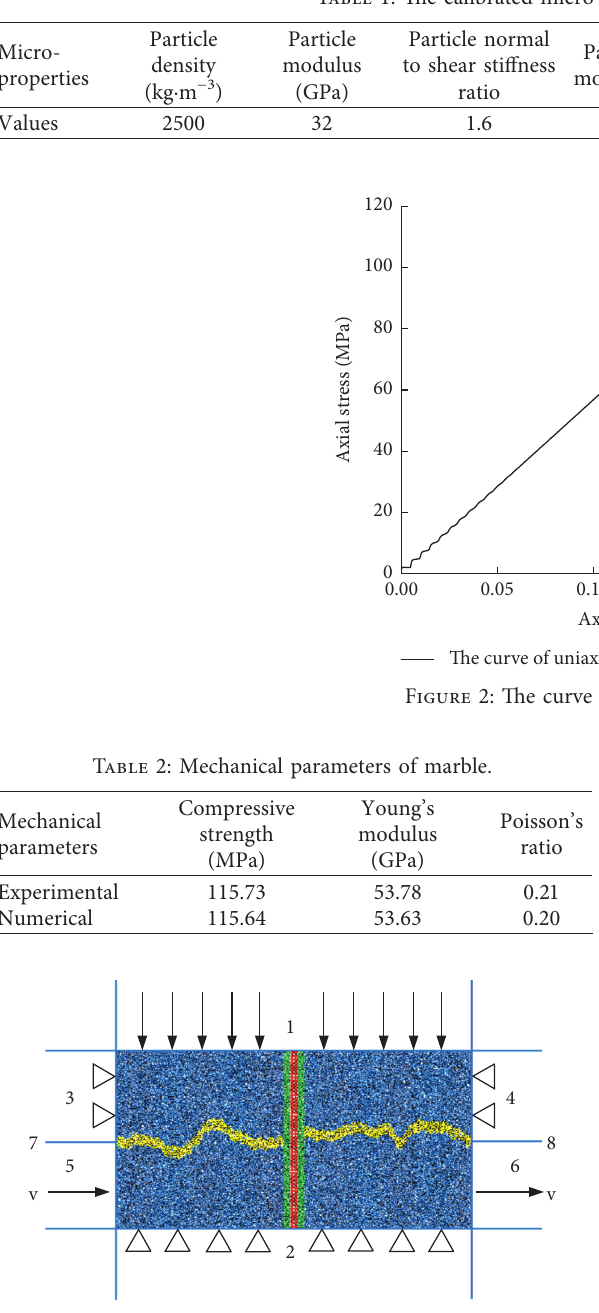
Figure 3: Schematic diagram of shear numerical model.